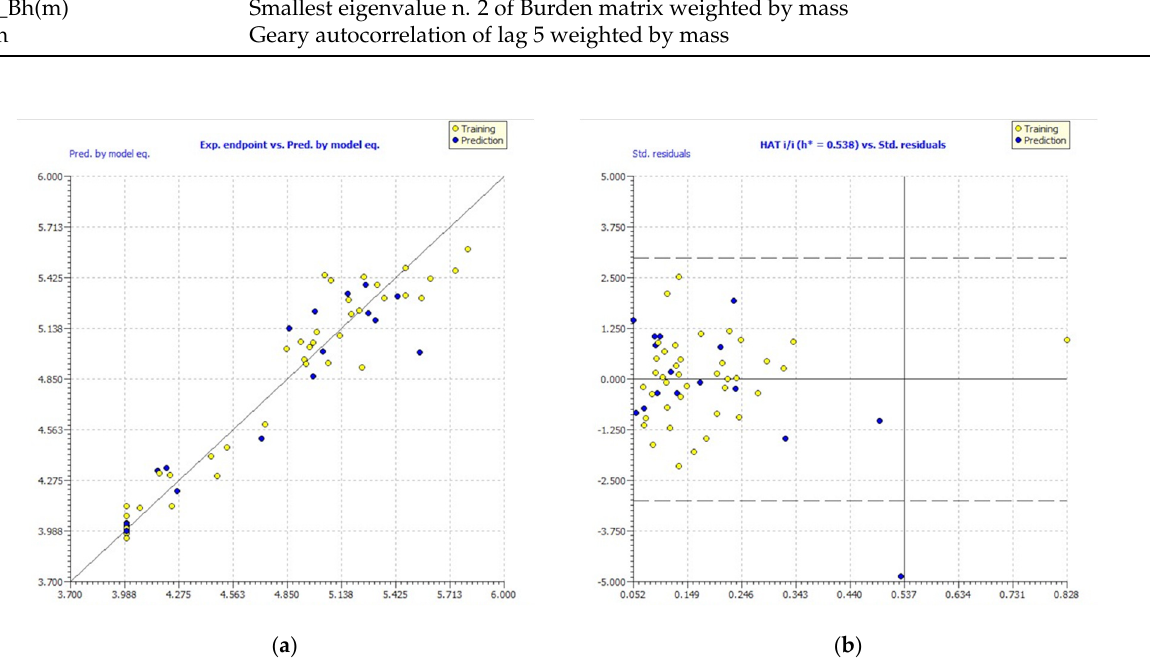
Figure 2. Experimental vs. predicted pIC 50 values computed by GA-MLR ( a ). William’s plot ( b ).